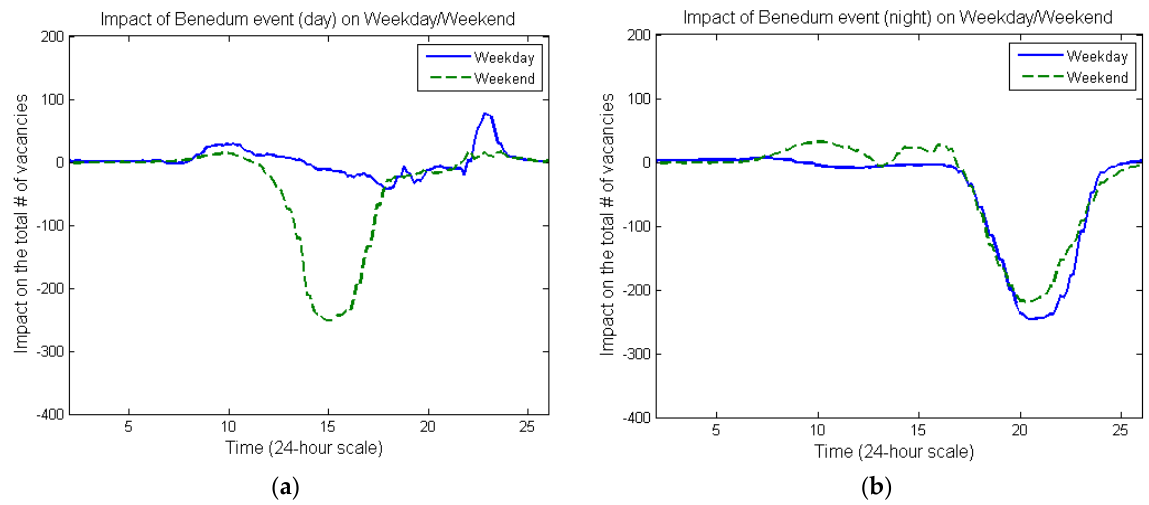
Figure 5. ( a ) Impact of Benedum Center event during daytime; ( b ) impact of Benedum Center event during